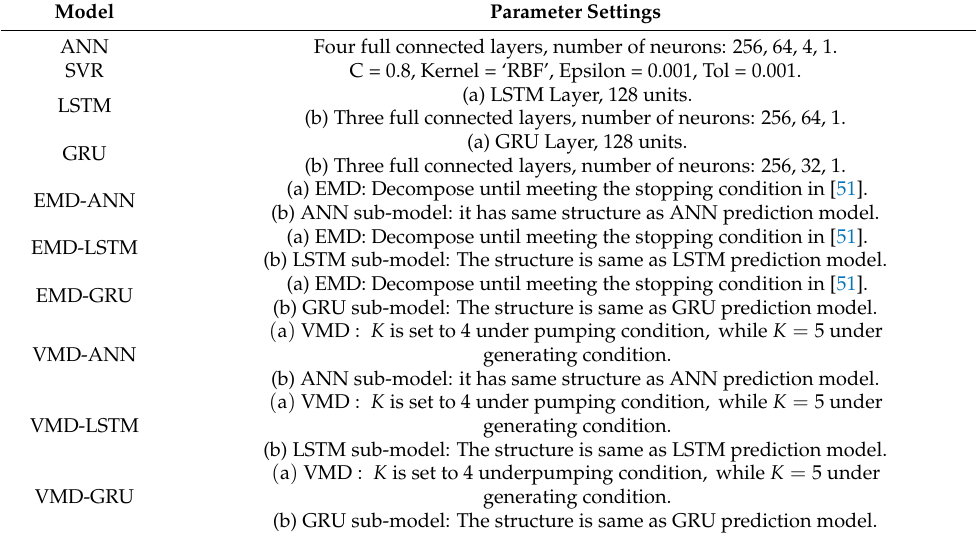
Table 3. Parameter setting of prediction models. Model Parameter